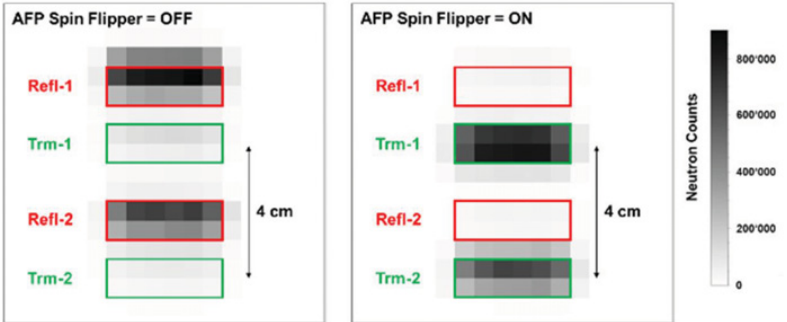
Figure 3. Detector counts in 10s at a wavelength of 0.48nm for the two adiabatic spin flip device states (off and on). The detector has an active area of 100 × 100mm 2 divided into 16 × 16pixels. The two beams cause four beam spots behind the spin analyzer – reflected (red box) and transmitted (green box) beam of the upper and lower beam, respectively.